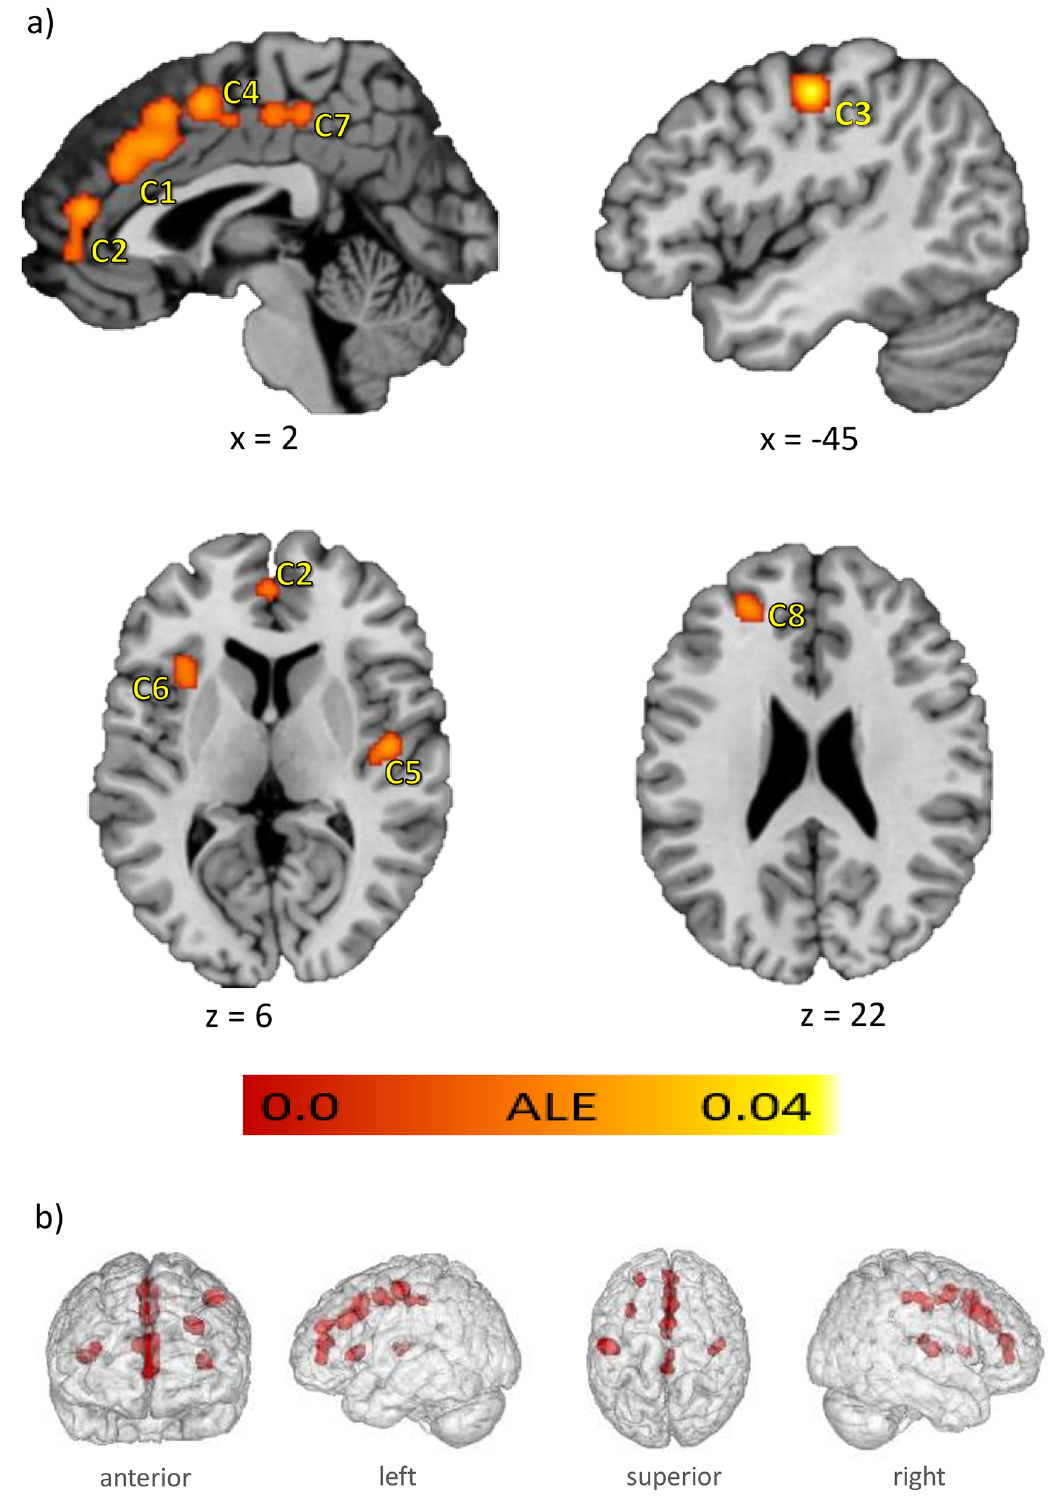
Figure 3. Results of the ALE meta-analysis. The highlighted clusters (C1–C8) represent significant convergence about grey matter differences in AUD patients compared to healthy controls. ( a ) Clusters are depicted on brain slices of an MNI standard brain. Color indicates ALE value. ( b ) Spatial position and expansion of the ALE- clusters depicted on a grey matter glass brain. Cluster-forming threshold p < 0.001, family wise error (FWE) cluster level corrected at p < 0.05. x, y and z values refer to coordinates in MNI space, for detailed MNI peak voxel coordinates of the ALE clusters see Table 2. This image was created with Mango v4.1. (http://ric.uthsc sa.edu/mango